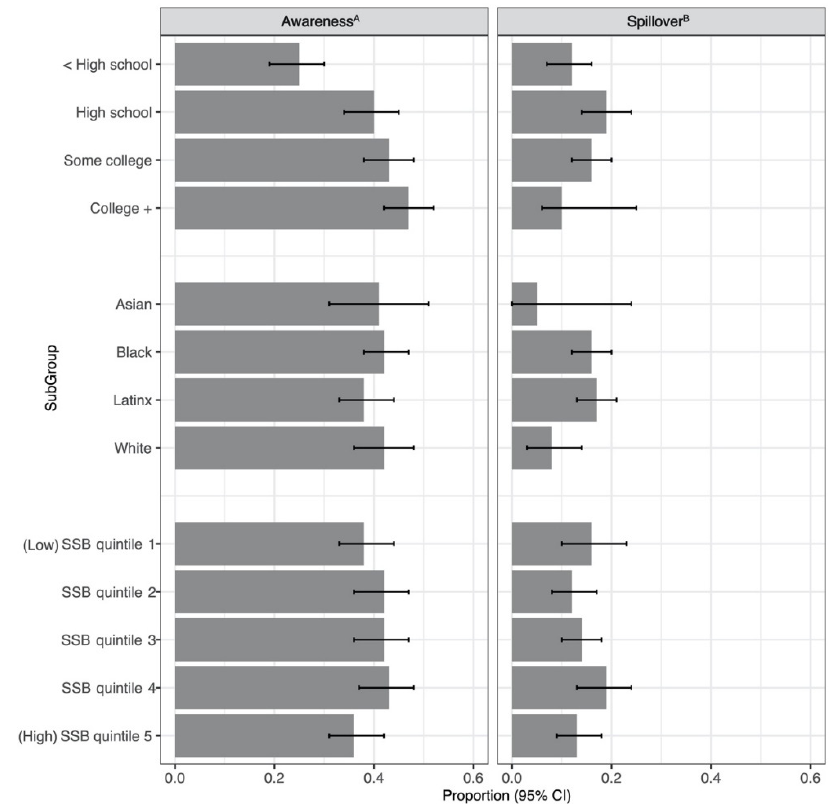
Figure 3. Adjusted proportion of respondents correctly (Awareness) and incorrectly (Spillover) recalling passage of a tax in prior year, by education, race/ethnicity, and quintile of SSB consumption. Adjusted marginal predicted probabilities from logistic mixed-effects model adjusting for quantile of SSB consumption, race/ethnicity, education, gender, and age, with random intercept for neighborhood. A In cities where a tax passed via ballot measure in prior year: Berkeley (2015), Oakland (2017), and San Francisco (2017), N = 1711. B In cities where a tax was not on the ballot in prior year: Oakland (2015) and Richmond (2017), N = 1004.